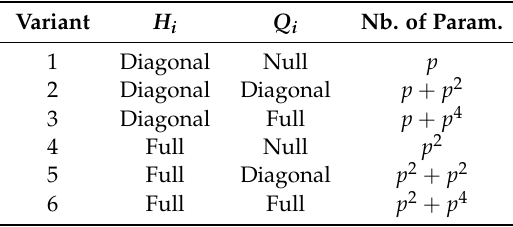
Figure 2. Functional State Space Model (SSM) flowchart in practice. Table 2. Variants considered for the model (6) showing different structures of matrices H i and Q i and number of unknown parameters as function of p